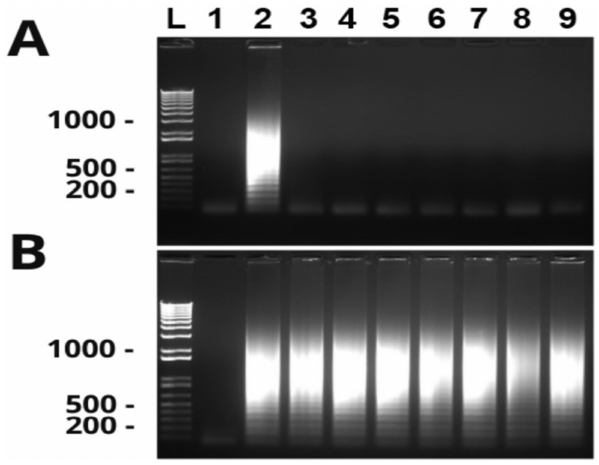
Figure 4. Detection of T. tenax without DNA extraction by newly developed LAMP assay. Serially diluted samples of T. tenax cells in PBS ( A ) or TE buffer ( B ) boiled at 100 ◦ C for 30 min: lanes 1 and 2: negative and positive controls without and with T . tenax genomic DNA (100 ng/ µ L); lanes 3–9: containing 2 × 10 5 , 2 × 10 4 , 2 × 10 3 , 2 × 10 2 , 2 × 10 1 , 2 × 10 0 and 2 × 10 − 1 cells, respectively. L: 100 bp DNA ladder maker. One of three repeats is